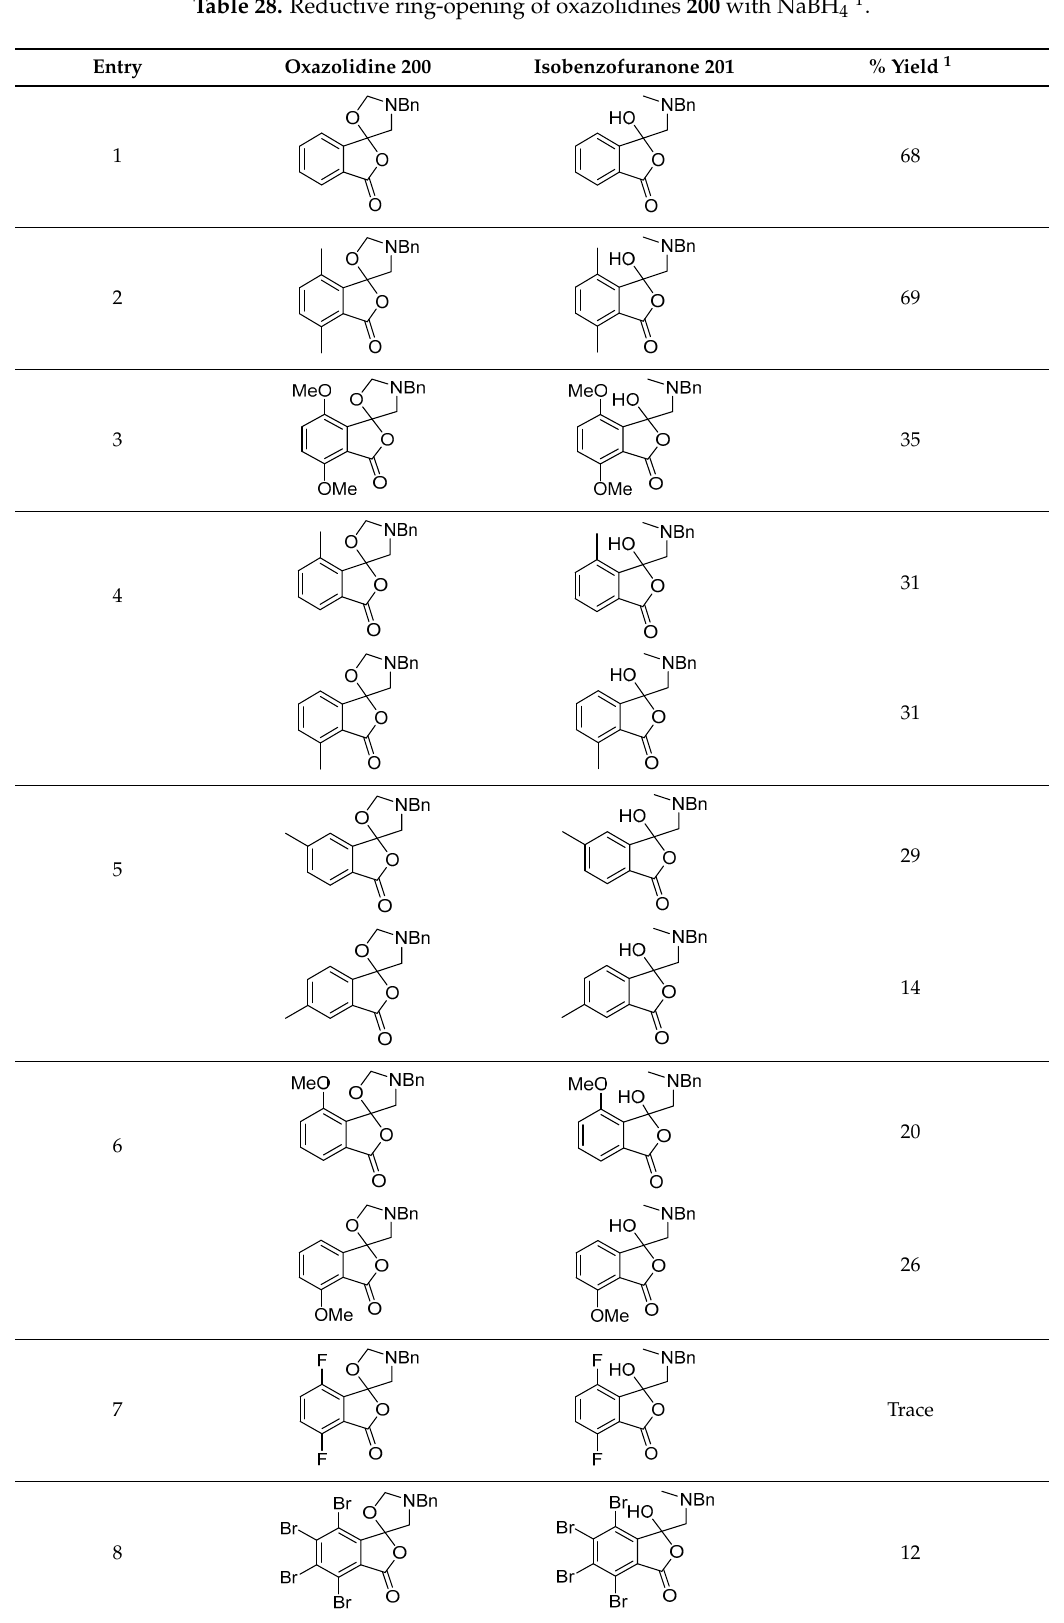
Table 28. Reductive ring-opening of oxazolidines 200 with NaBH 4 1 .